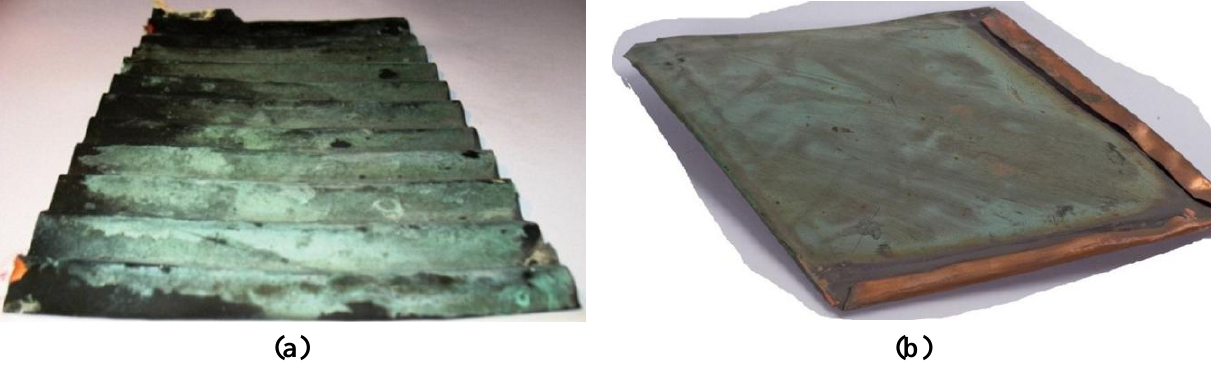
Figure 1. Old copper roofing samples: (a) from Wilanów Palace in Warsaw; (b) from the dome of Karol Poznański Palace in Łódź,